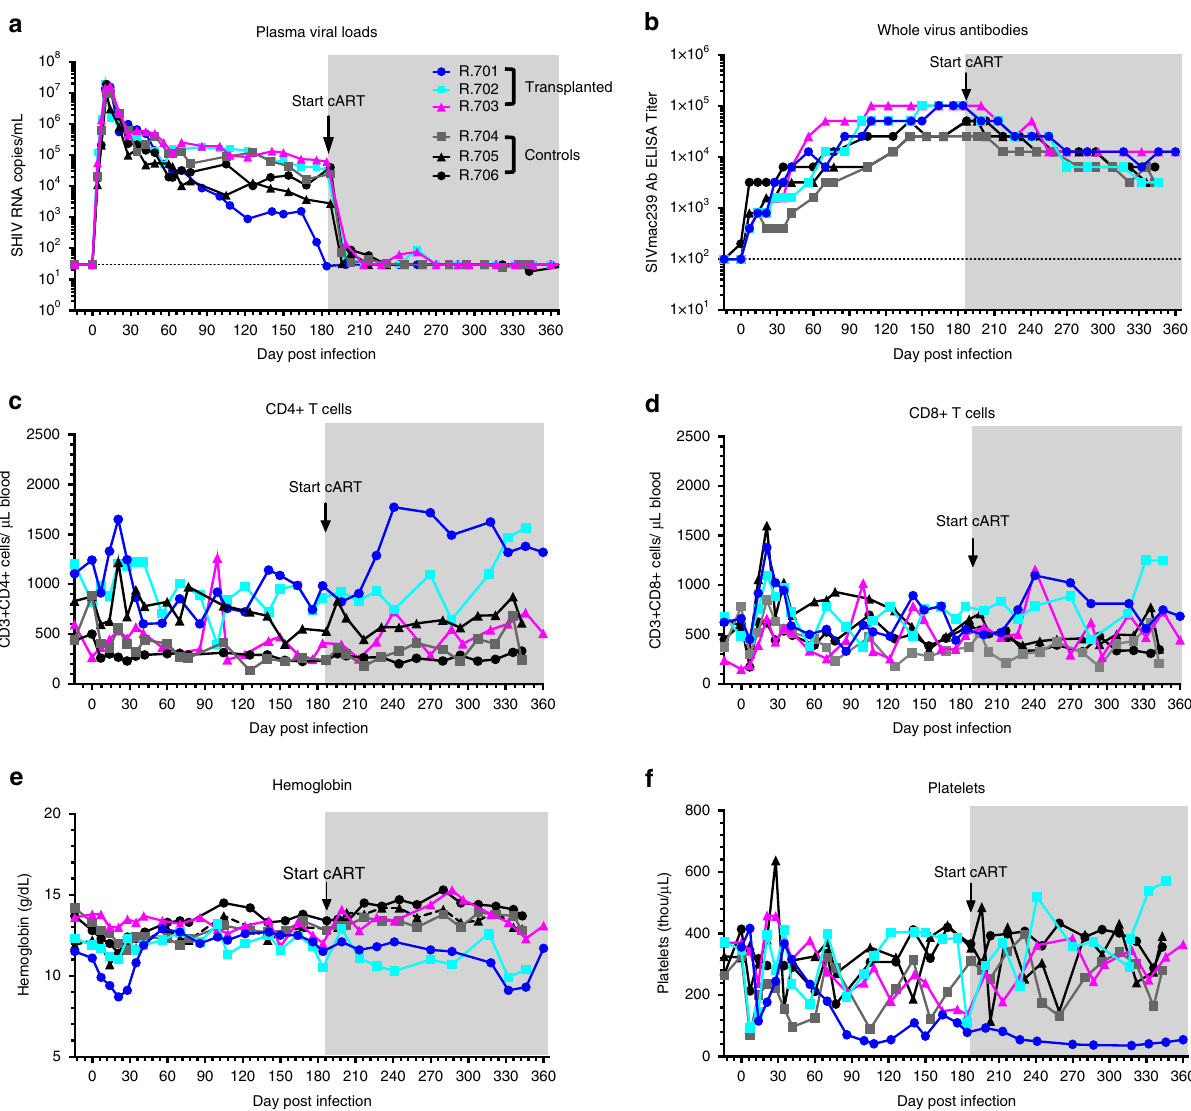
Fig. 1 Impact of SHIV-C Infection and cART Treatment. Six rhesus macaques were infected intravenously (IV) with SHIV1157ipd3N4 (SHIV-C) and monitored for at least one year prior to allogeneic transplantation. a Plasma Viral Loads (PVL) were monitored by quantitative real-time PCR (qPCR) bi- weekly after challenge. cART (PMPA/FTC/Raltegravir) was initiated 6 months post-infection and continued thereafter. The dashed line marks the limit of detection (LOD) of the qPCR = 30 copies/mL. The arrows indicate the day of cART initiation, and the gray shaded areas indicate continuous cART treatment . b Whole virus SIVmac239-reactive antibody titers. c Peripheral blood CD4 + and d CD8 + T cell counts. e Hemoglobin (Hgb) concentration (g/ dL). f Platelet counts (x10 3 / µ animals developed mild anemia (Fig. 1e) and thrombocytopenia (Fig. 1f) during peak viremia, without signi fi cant variation thereafter. It should be noted that while fi ve of the six RM studied (Animal ID# R.701) developed a clinically signi fi cant viral syn- drome, including weight loss, lymphadenopathy, and skin rash within 30 days of infection, and displayed a lower peripheral blood viral load compared to the other animals (Fig. 1a). The potential immune reaction to SHIV was accompanied by a sig- ni fi cant drop in the platelet count (Fig. 1f). In short, our cohort of animals displayed typical courses of unsuppressed SHIV viremia and responded as expected to cART.